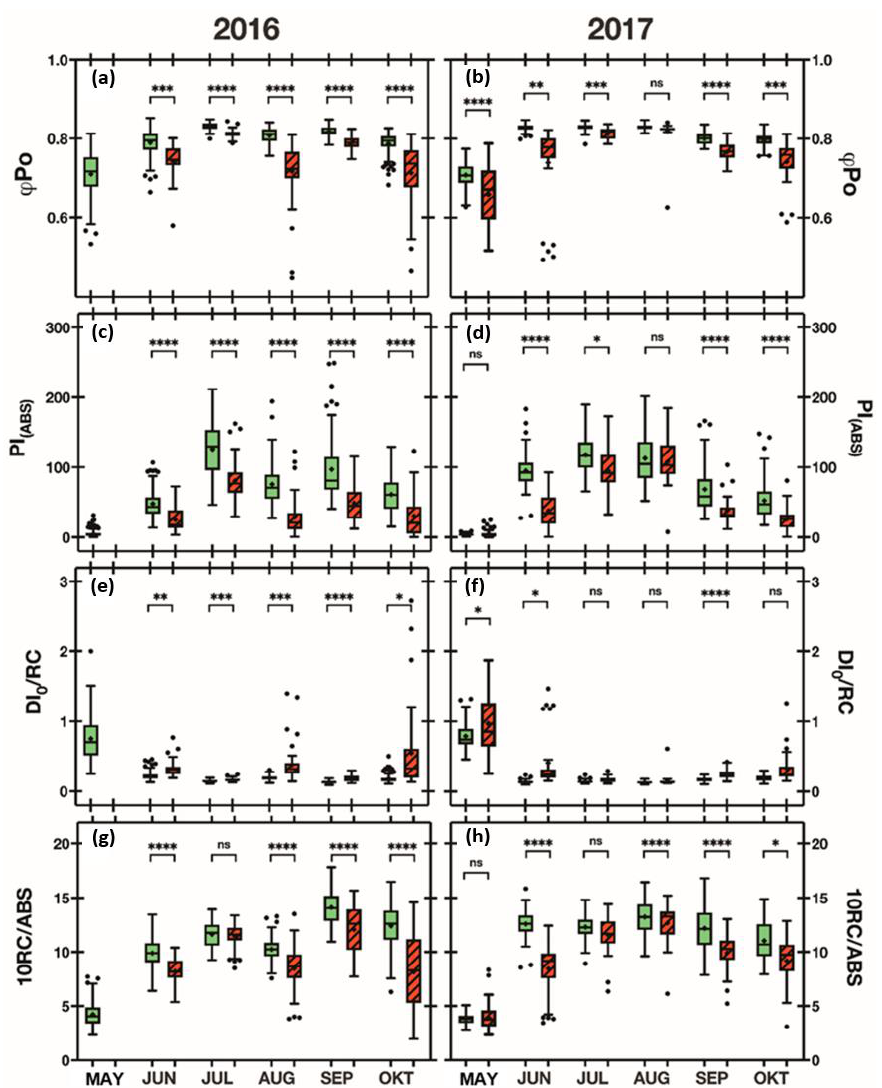
Figure 4. Comparison of photosynthetic performance and stress parameters. OPM-infested leaves of oak (red colour) and non-infested leaves (green colour) in a forest area. Stölln, Gollenberg, Brandenburg. May to October 2016 and 2017. ( a , b ) Po = PHI Po = Fv/Fm = quantum efficiency of PS II, indicator for the general condition of the leaves. ( c , d ) PIABS = Performance Index, indicator for the efficiency of the photosynthetic light reaction up to the start of PS I. ( e , f ) DIo/RC = Energy loss of the photosynthetic reaction centre, targeted heat release as protection against over-energisation of the photosystem, protection against cell damage. ( g , h ) 10RC/ABS = Degree of opening of the reaction centre in PS II, which indicates how well light energy can be absorbed for photosynthesis. Displayed in boxplots with Tukey interval. Cross-lines in boxes, median. Crosses, mean values. Significances calculated by analysis of variance (one-way ANOVA). Significance level: ns = p > 0.05; * = p < 0.05; ** = p < 0.01; *** = p < 0.001; **** = p < 0.0001.